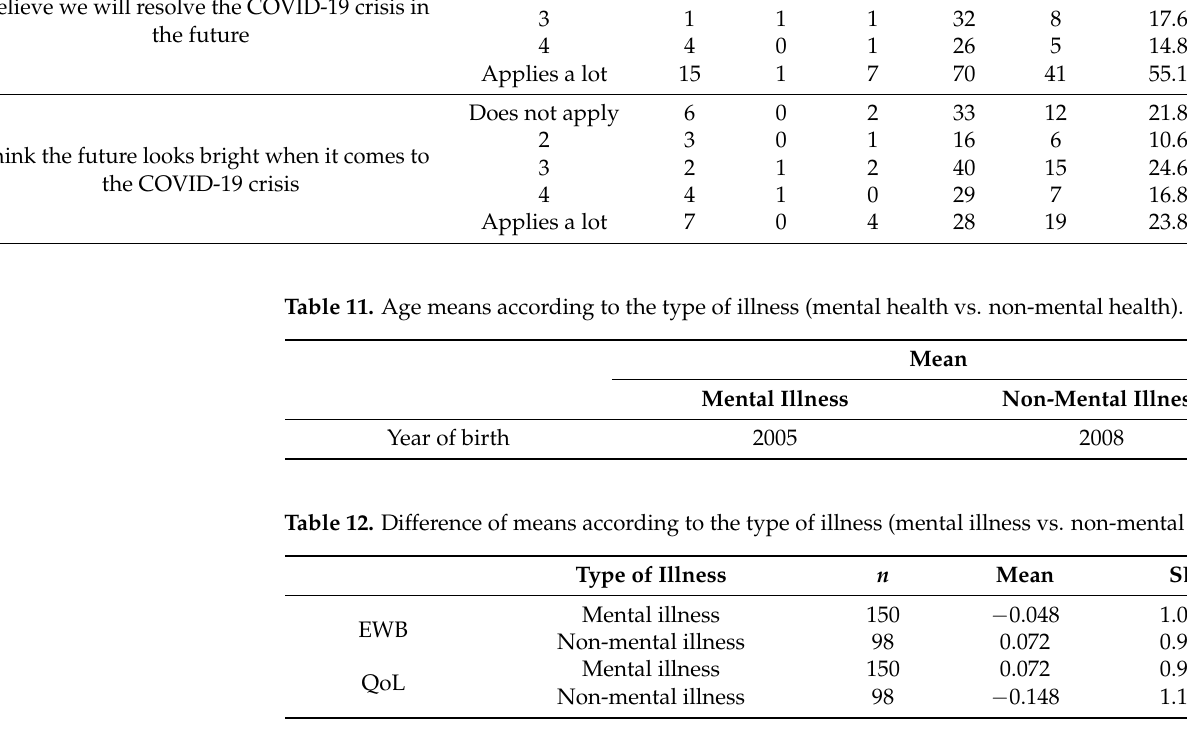
Table 13. Independent samples